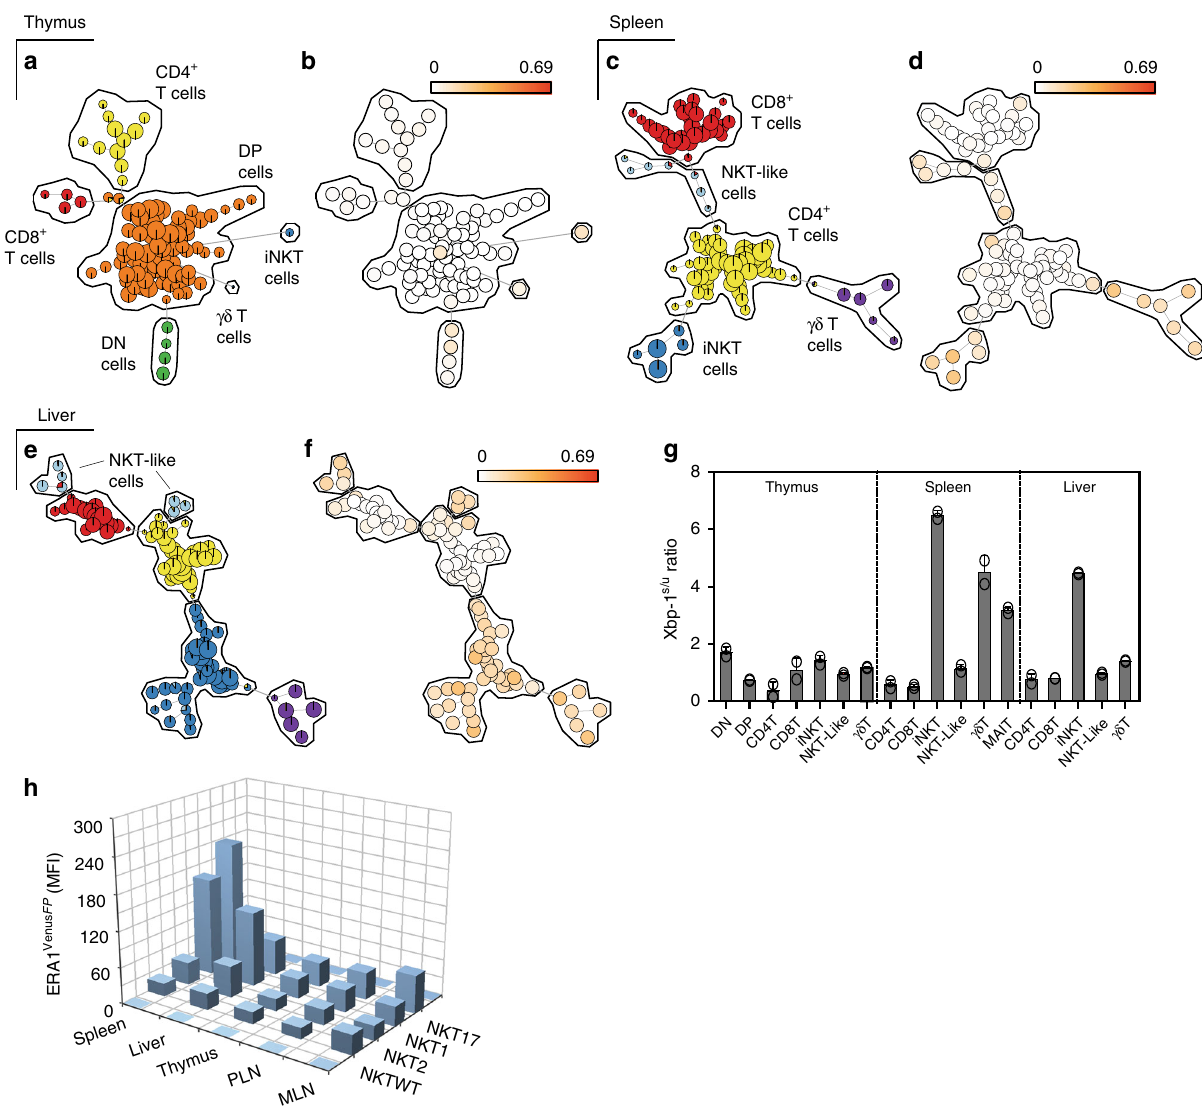
Fig. 1 Constitutive IRE1 α RNase activity in iNKT cells of naïve ERA1- mice. a − f Minimal spanning tree visualization of T-cell subsets by FlowSOM analysis. Manual gating results for a thymus, b spleen and c liver indicate which nodes correspond to the indicated T-cell subsets. Node size corresponds to the percentage of cells represented by each node. b , d , f Venus FP expression within ERA1 FP/WT and control ERA1 WT/WT mice for thymus, spleen, and liver, respectively ( n = 3). Data represent three independent experiments. g Xbp-1s/u mRNA ratio expressed by T-cell subsets isolated from thymus, spleen, and liver of C57Bl/6 mice ( n = 5). Bar chart represents two independent experiments pooled. h Venus FP MFI within NKT1, 2 and 17 cells isolated from thymus, spleen, PLN, MLN, and liver of ERA1 FP/WT mice ( n = 3). iNKT WT represents Venus FP MFI within control iNKT cells isolated from WT mice. Bar chart represents one of three independent experiments. T lymphocyte subsets in ( a − g ) are de fi ned in Materials and Methods. Error bars show the mean ± signaling within iNKT cells induces activation of the kinase IFN 28,29 . We initially examined the role of TCR-dependent sig- domain of IRE1 α . A subsequent analysis of the ability of addi- naling in regulating IRE1 α RNase activity within iNKTs by sti- tional stimuli to induce Xbp1 mRNA splicing within in vitro mulating splenic iNKT sublineages in vitro using anti-CD3/ expanded iNKT cells revealed that neither cytokines such as IL- CD28. For these experiments, splenic NKT1 a , NKT1 b , NKT2, and 12p70 and IFN β , nor Toll-like receptor (TLR) agonists such as NKT17 sublineages were FACS sorted based on CD27 and lipopolysaccharide (LPS) or Poly (I:C) induced signi fi cant IRE1 α CD122 cell-surface expression and expanded in vitro as has been RNase activity above that observed for medium controls (Fig. 2d). previously reported 26,27 . Subsequent in vitro restimulation of These results were con fi rmed in vivo using ERAI FP/WT mice iNKT sublineages revealed that TCR-dependent stimulation induced pronounced splicing of Xbp1 mRNA (Fig. 2a), as well as (Fig. 2e − h). Here, intraperitoneal (i.p.) administration of α - several UPR-associated mRNAs (Fig. 2b) within the NKT17 and galactosylceramide ( α -GalCer), a TCR ligand, signi fi cantly NKT1, but not NKT2 sublineage cells. Importantly, we show that increased Venus FP expression within splenic and hepatic TCR-induced splicing of Xbp1 mRNA within restimulated iNKT cells when compared to vehicle controls (Fig. 2e − h). In iNKT cells (Fig. 2a) is associated with increased autopho- contrast, induction of type 1 IFN following administration of Poly sphorylation of IRE1 α (Fig. 2c), suggesting that TCR-mediated (I:C) failed to modulate expression of Venus FP within iNKTs